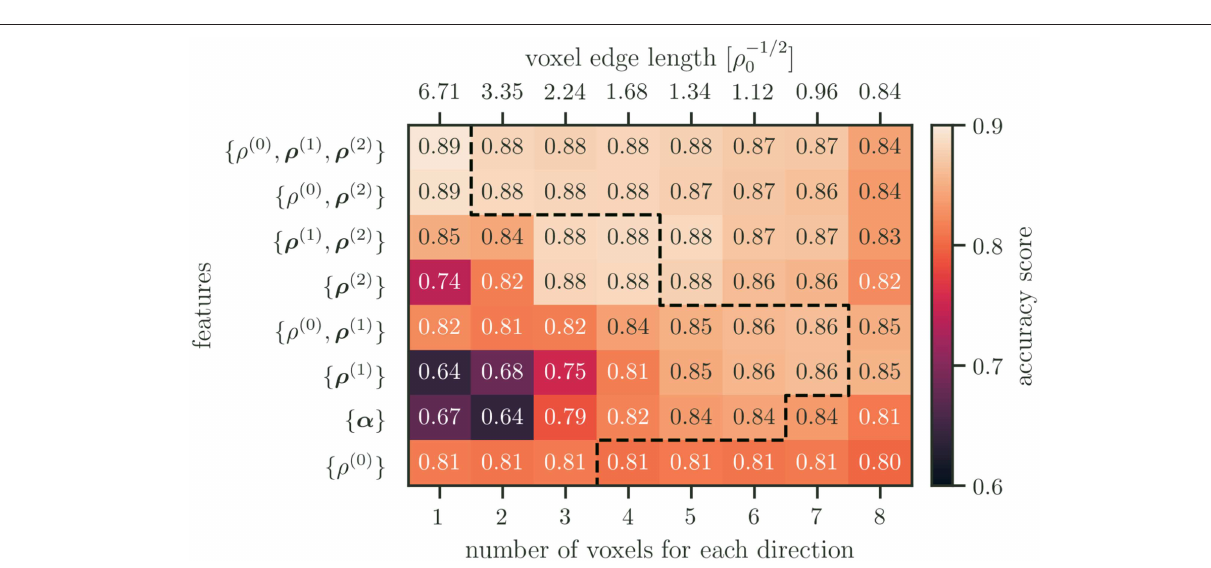
FIGURE 8 | Accuracy scores for all feature combinations and resolutions. The features are ordered by their maximum accuracy score, with the best performing features on top. The dashed line indicates the point after which an increase in resolution results in worse